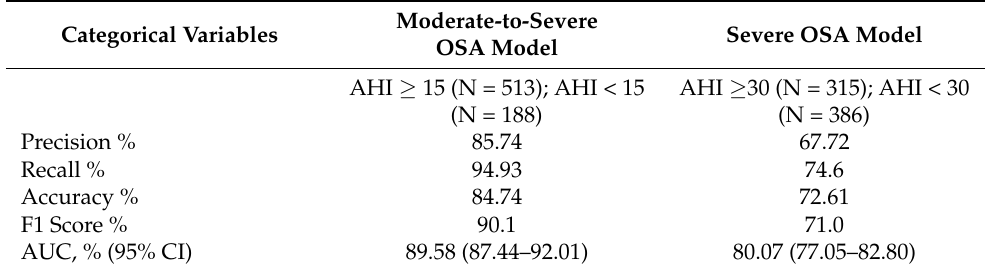
Table 5. Classification of the results of the random forest model for screening moderate to severe and severe risks of OSA by using the testing data